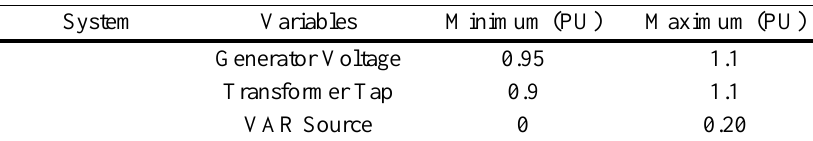
Table 10. Constraints of control variables.